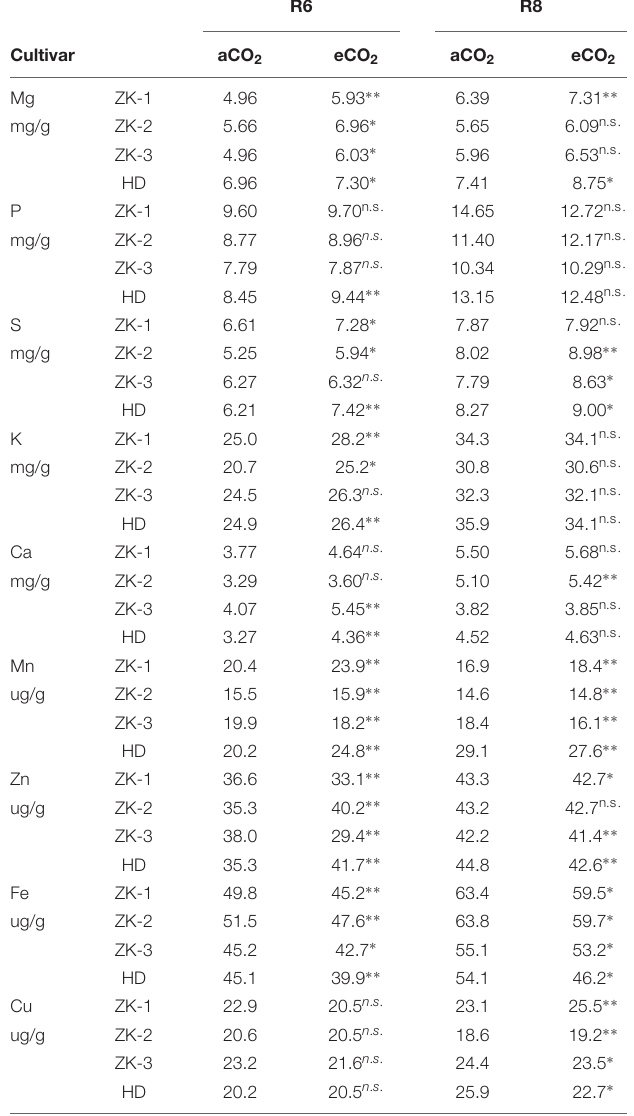
TABLE 2 | Effect of eCO 2 on soybean seed element concentrations at R6 and R8. R6 R8 Cultivar aCO 2 eCO 2